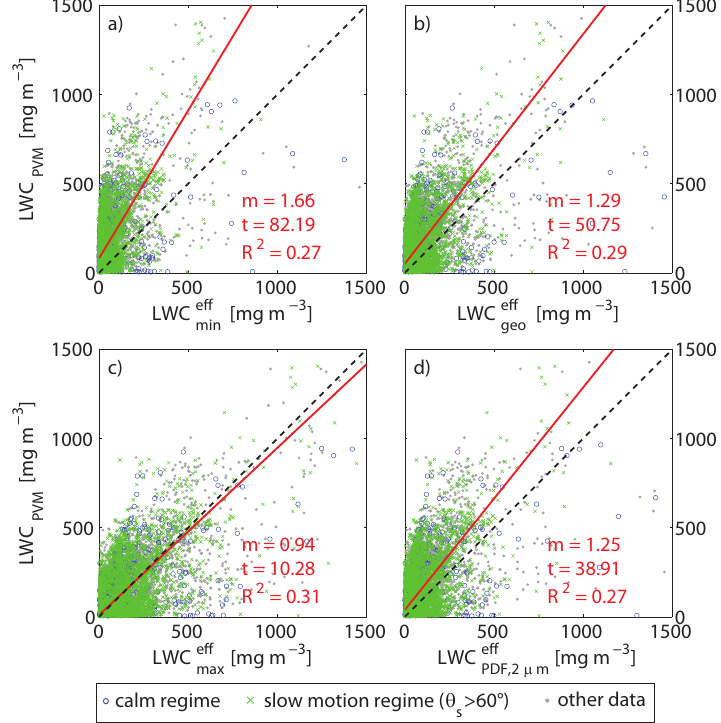
Fig. 11. Effect of particle losses (using TR corrections – see Table 3 – for all data) on the LWC for LWC min , LWC geo , LWC max and LWC PDF , 2 µ m for CLACE 2010 (blue circle: U 0 < 0.5ms − 1 ; green crosses: 0.5 <R v < 0.8 and θ s > 60 ◦ ; gray dots: rest of the data fulfilling the cloud criterion). The solid red line represents a geometric mean regression with m : slope, t : intercept and R 2 : squared correlation